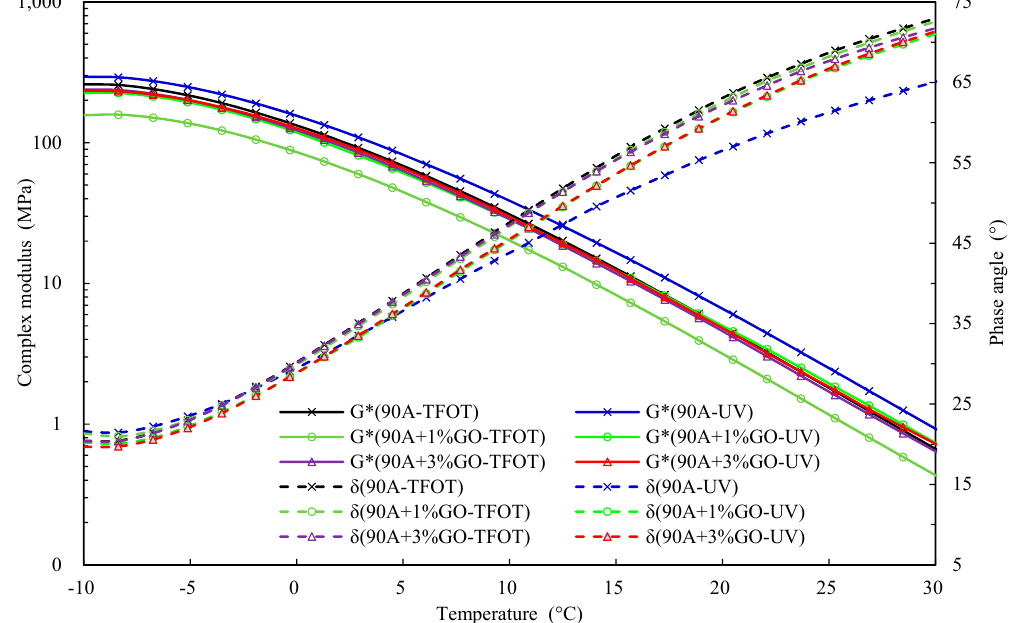
Figure 10. Complex modulus of 90 A and GO modified 90 A after TFOT and nine days of UV aging.